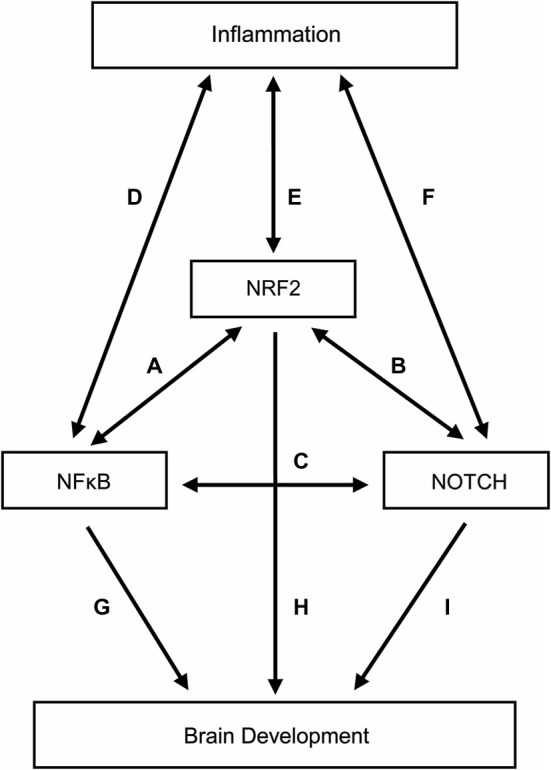
Relationships among inflammation, three transcription factors (NF-κB, NRF-2, and Notch), and brain development. To minimize complexity, the contributions of NF-κB, NRF-2, and Notch to brain damage in adults are not included in this figure. The letters adjacent to the lines identify a selected set of citations that support the existence of a relationship indicated by the line. (A) (Liu et al., 2008; Buelna-Chontal and Zazueta, 2013; Ganesh Yerra et al., 2013; Sandberg et al., 2013; Yang et al., 2013a,b; Djordjevic et al., 2015). (B) (Yang et al., 2013a; Kim et al., 2014; Wakabayashi et al., 2014). (C) (Ang and Tergaonkar, 2007; Hurlbut et al., 2007; Scholzke and Schwaninger, 2007; Osipo et al., 2008; Poellinger and Lendahl, 2008; Yang et al., 2013a; Yao et al., 2013b; Li et al., 2014; Yu et al., 2014). (D) (Covert et al., 2005; Werner et al., 2005; Liu et al., 2008; O’Dea and Hoffmann, 2009; Kim et al., 2011; Ruland, 2011; Bartuzi et al., 2013; Bakunina et al., 2015; Zhao et al., 2015). (E) (Kumar et al., 2012; Brune et al., 2013; Ruiz et al., 2013; Sandberg et al., 2013; Bakunina et al., 2015; Zhao et al., 2015). (F) (Hoyne et al., 2001; Arumugam et al., 2006; Fung et al., 2007; Fernandez et al., 2008; Palaga et al., 2008; Ito et al., 2012; Wongchana and Palaga, 2012; Zhang et al., 2012; Radtke et al., 2013; Yao et al., 2013b; Cheng et al., 2015). (G) (O’Dea and Hoffmann, 2009; Crampton and O’keeffe, 2013; Snow et al., 2014). (H) (Gupta et al., 2013). (I) (Wang et al., 1998; Oya et al., 2009; Imayoshi et al., 2013; Yao et al., 2013a; Kotasová et al., 2014; Schwanbeck, 2015).